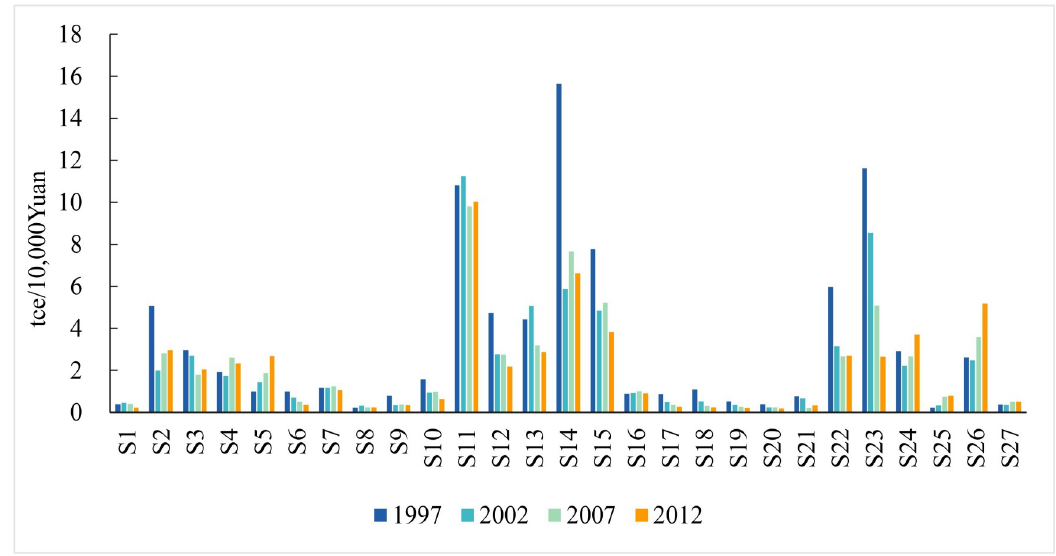
Fig 1. Comparison of Chinese sectoral energy intensities in 1997, 2002, 2007, and 2012.4.1.2. Household indirect energy consumption.